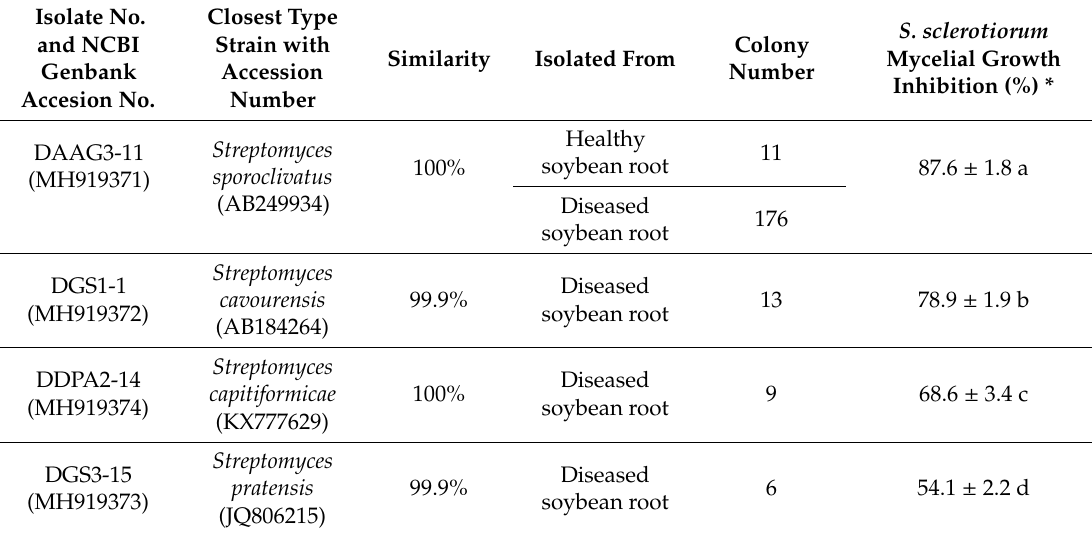
Table 1. Antagonistic potential endophytic actinobacteria isolated from healthy and diseased soybean root, and similarity values for 16S rRNA gene